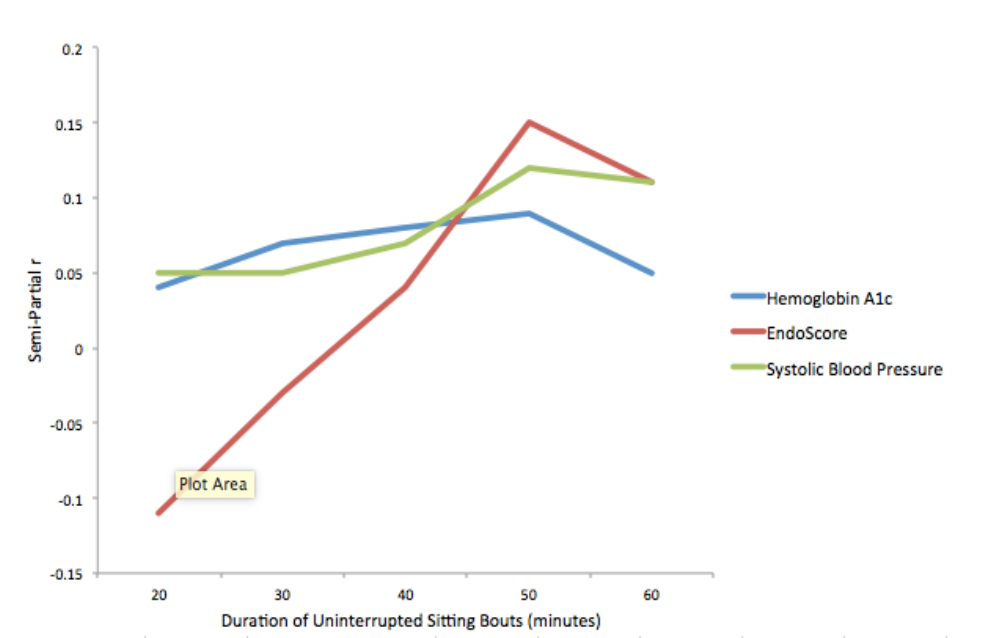
Figure 3. Semi-partial correlation coefficients for relationships between physiological markers and uninterrupted sitting bouts, while controlling for physical activity outside of work. Table 4. Descriptive Statistics for Physical Activity and Postural Classifications.